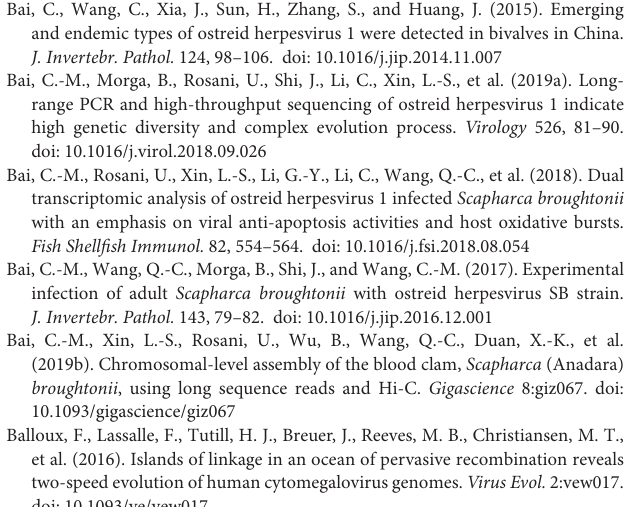
number (viv57-11) and the final status at the end of the experimental infection “v” stand for alive (viv57-11-v3) and “m” for dead (viv57-11-m99). Supplementary Figure 2 | Reconstructed local viral haplotypes for four samples using Haploclique (Töpfer et al., 2013). The X-axis represents a genomic position within OsHV-1 reference genome in base pair; the Y-axis is the number of haplotypes reconstituted at the focal genomic position. Large deletions are visible in the sequencing top panels and in the number of reconstructed haplotypes. Supplementary Figure 3 | Local viral haplotype reconstruction using QuasiRecomb software on genomic regions without any abrupt drop of sequencing depth (large deletions). Reconstructions have been done on CDS basis (using the reference genome annotation from Davison et al. (2005). The X-axis represents the genomic position within the reference viral genome. The Y-axis is the number of quasispecies. The black number corresponding to ORF. In red, we represented the larges deletion found in the consensus viral genome of each isolates, orange illustrate genomic regions where the alignment was not good enough to allow haplotype reconstruction. Large deletions were detected after visual inspection of bam file and sniffles detection. Supplementary Figure 4 | Illustration of the variety of polymorphism found in OsHV-1 genome mapped against the reference genome from Davison et al. (2005). Some visual patterns observed in Bam files motivate the search of viral haplotypes. Here both Bam and Vcf files are viewed using IGV (Thorvaldsdóttir et al., 2013). The blue arrowed highlights some detected polymorphisms and red arrows point out undetected potential variants. Horizontal arrows showed the large deletions, i.e., structural variations, and vertical arrows pointed out short polymorphism, i.e., short indel and SNPs. Each picture (one per sample) is composed of a bandplot showing the sequencing depth (top panel) of the considered genomic regions followed by the alignment of individual reads (bottom panel). The sequencing depth is between 0 and 4,000 X for the LI and SW6 samples, and 0–190 for NZ17 samples. (A) The observed region is from 94,000 to 100,000 bp on LI, NC17, and SW6 isolates. (B) The observed region is from 71,400 to 73,000 bp. (C) Zoom in the 77,900–79,000 bp in the NZ17 samples, it seems that there is a physical linkage between a short deletion and a SNP leading to conclusion that there are at least two haplotypes segregating in this region. (D) Zoom in the 21,700–22,800 bp region of the SW6 samples. The extremely large sequence depth of this sample allows to infer that few haplotypes segregating in this population show duplication. Supplementary Figure 5 | Clock-likeness of OsHV-1 genomes. Regression of root-to-tip genetic distance against sampling time were computed using TempEst v1.5.3 (Tan et al., 2015) using two rooting methods (best fit in TempEst and midpoint). Sufficient and robust temporal signal was observed to proceed with phylogenetic molecular clock